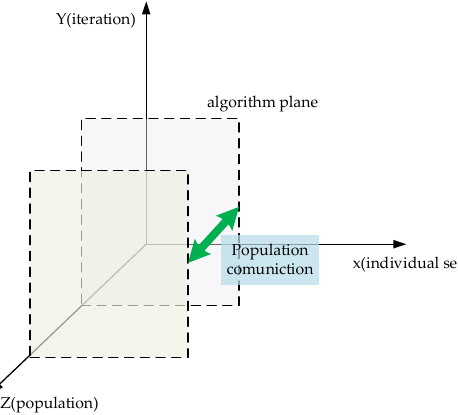
Figure 1. A three-dimensional model for population-based intelligent optimization algorithm.